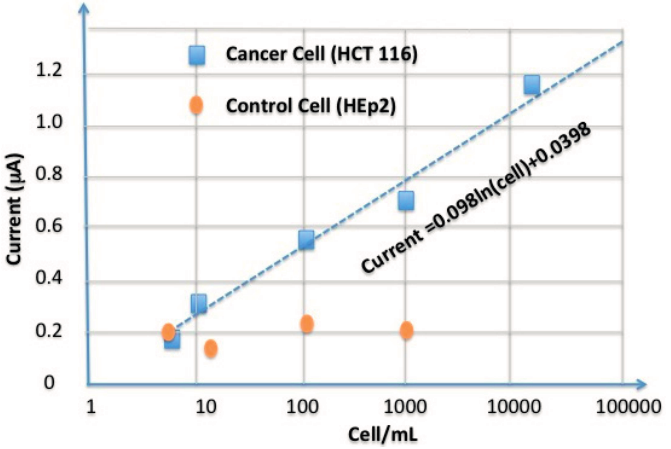
Figure 10. Calibration curve for cancer cells (HCT 116) and control cell